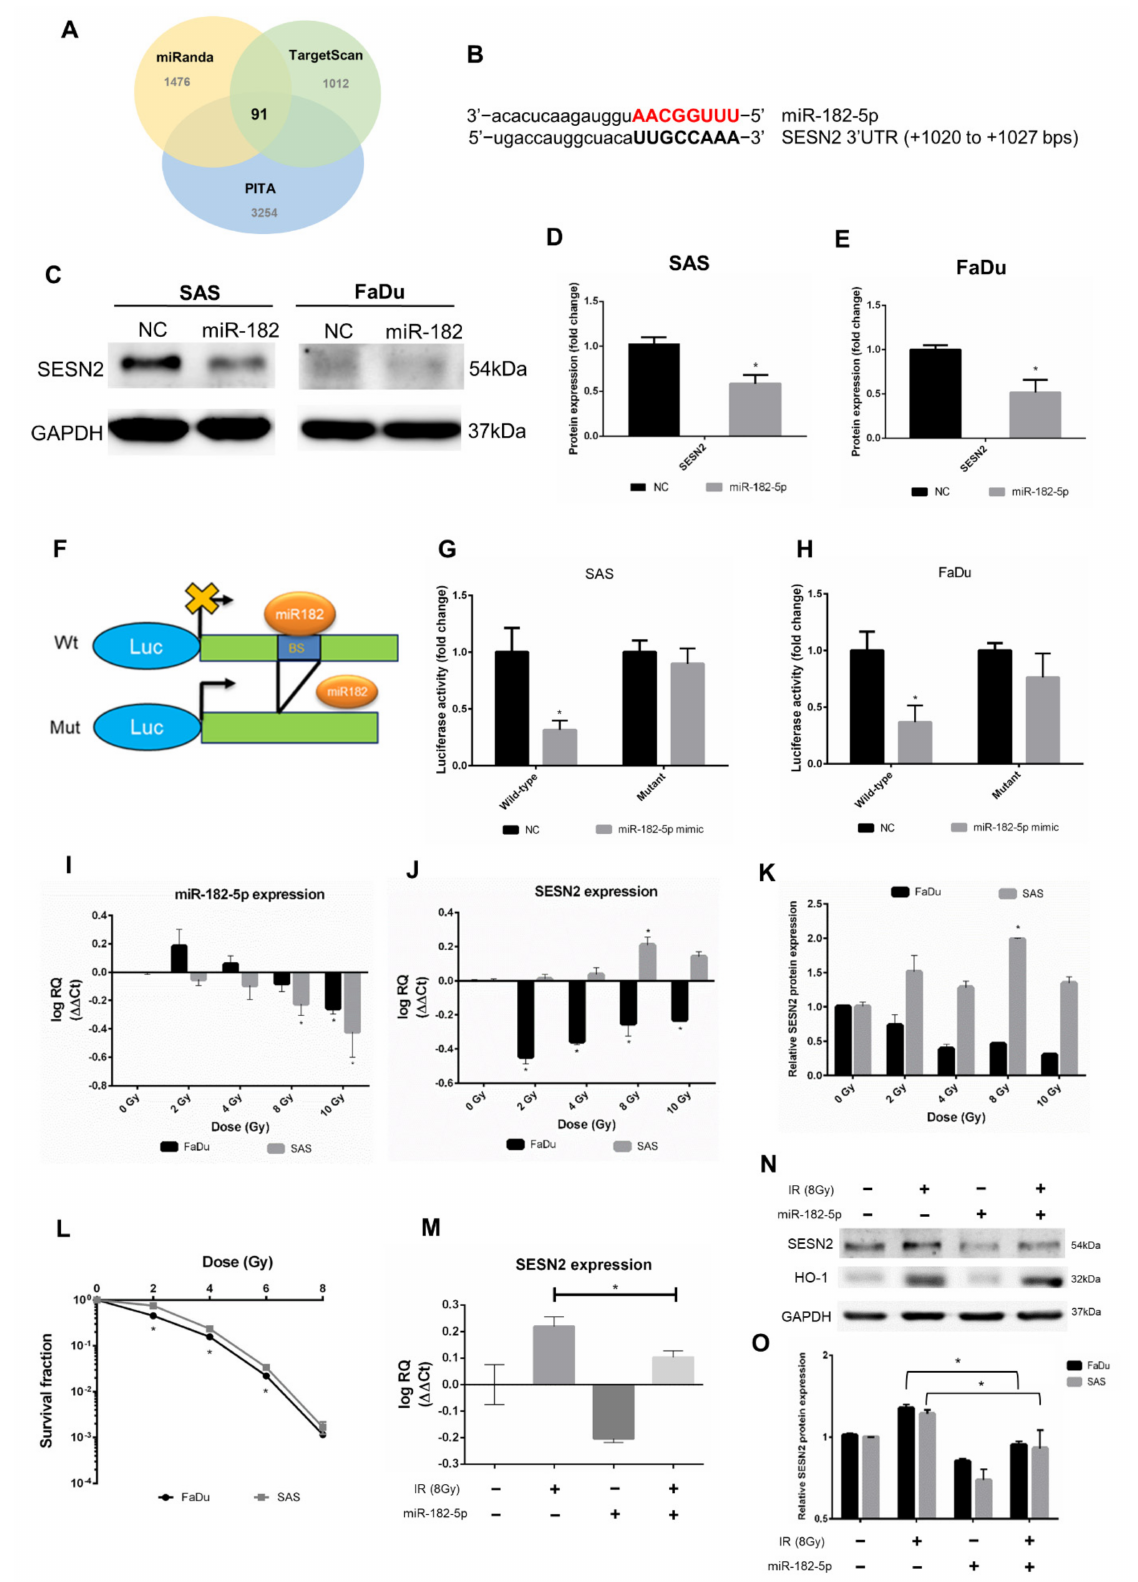
Figure 4. Targeting the antioxidant SESN2 gene by miR-182-5p dose-dependent irradiation. ( A ) Core analysis was performed using the Venn diagram. Three microRNA databases were analyzed to predict potent mRNA interactions with miR-182-5p (CLIP-seq Number >10). ( B ) Sequence complementary between miR-182-5p and the 3’UTR of SESN2. ( C ) Western blot analysis for detection of the expression of SESN2 in HNSCC cells with or without transduction of miR-182-5p. ( D , E )